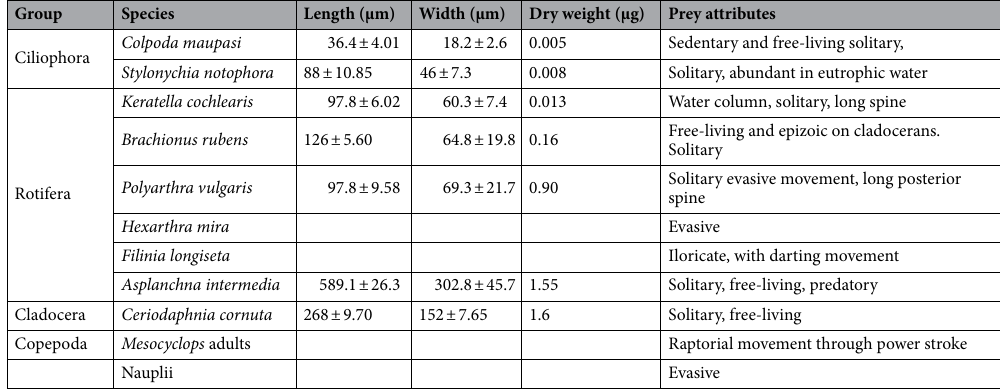
Table 1. Length, width and dry weight of different prey species used in the feeding trial experiments values given are mean ± SE (n = 20).